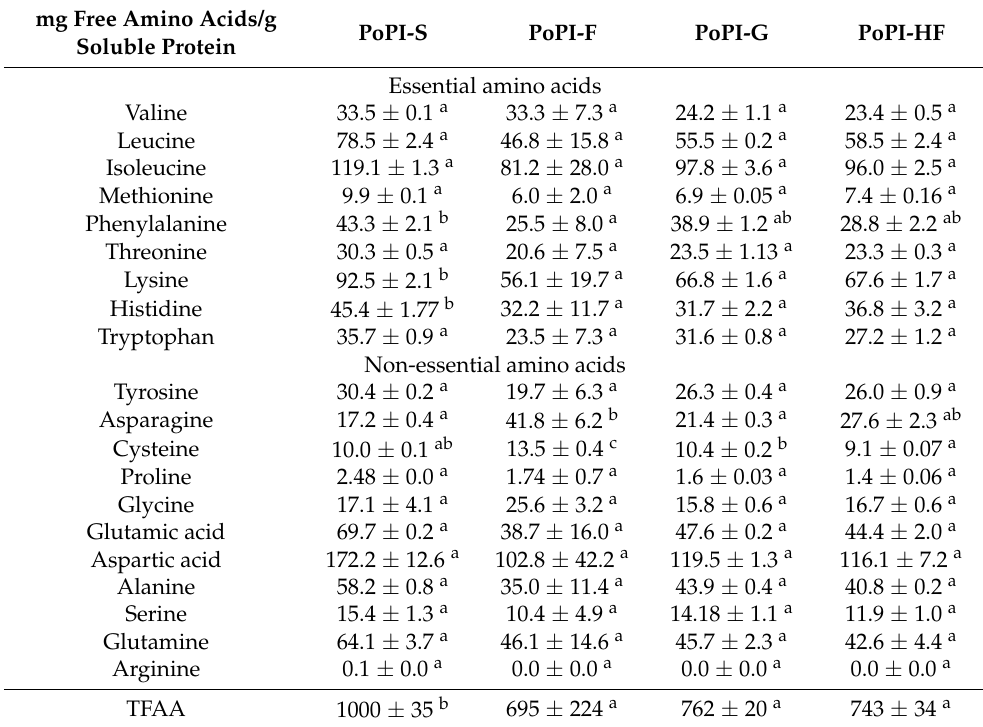
Table 2. Free amino acid values obtained by LC/TQ-MS measured after in vitro intestinal digestion (I5). Unheated suspension (PoPI-S), gel (PoPI-G), foam (PoPI-F), heat-set foam (PoPI-HF). The values are expressed as mg of free amino acid per g soluble potato protein in the intestinal point (I5). Values are reported as average of two replicates with standard deviation. The amount of total free amino acids (TFAA) is also shown: total free amino acids. Values highlighted in bold correspond to limiting amino acids (lysine and histidine). Different letters indicate statistically significant differences between treatments for a given amino